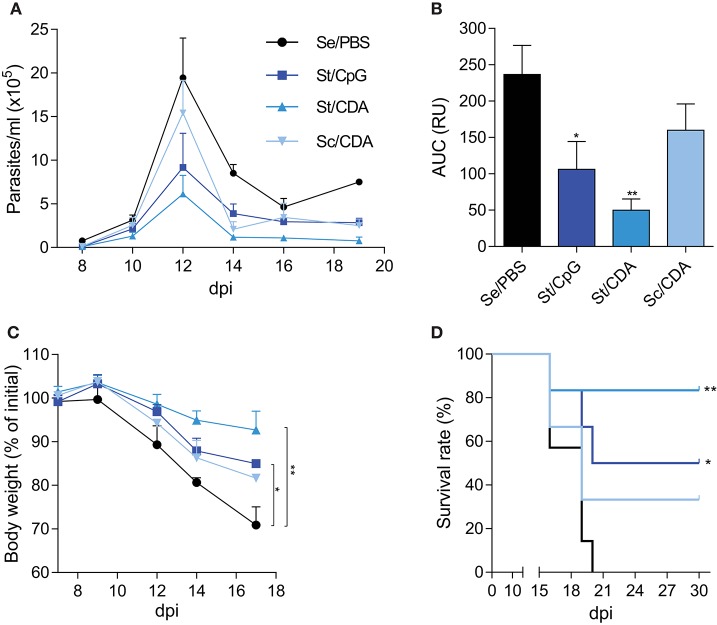
Improved efficacy in St/CDA vaccinated mice upon a lethal challenge with T. cruzi RA strain. Female C3H mice were vaccinated and 15–30 days after last dose were intraperitoneally infected with 1,000 blood trypomastigotes of T. cruzi RA strain (A) Parasitemia. (B) Area under the curve (AUC) of parasitemia up to 14 dpi. RU, relative units **p < 0.01, *p < 0.05 differences were calculated with respect to Se/PBS control group, one-way ANOVA + Bonferroni post-hoc test. (C) Weight loss. Results are expressed as percentage with respect to pre-infection **p < 0.01, *p < 0.05 at 17 dpi between the indicated groups, one-way ANOVA + Dunnett post-test. (D) Survival rate. Asterisks indicate significant difference with respect to Se/PBS control group. **p < 0.01, *p < 0.05 Log-rank test. n = 5–7 mice per group. Results are representative of three independent experiments.